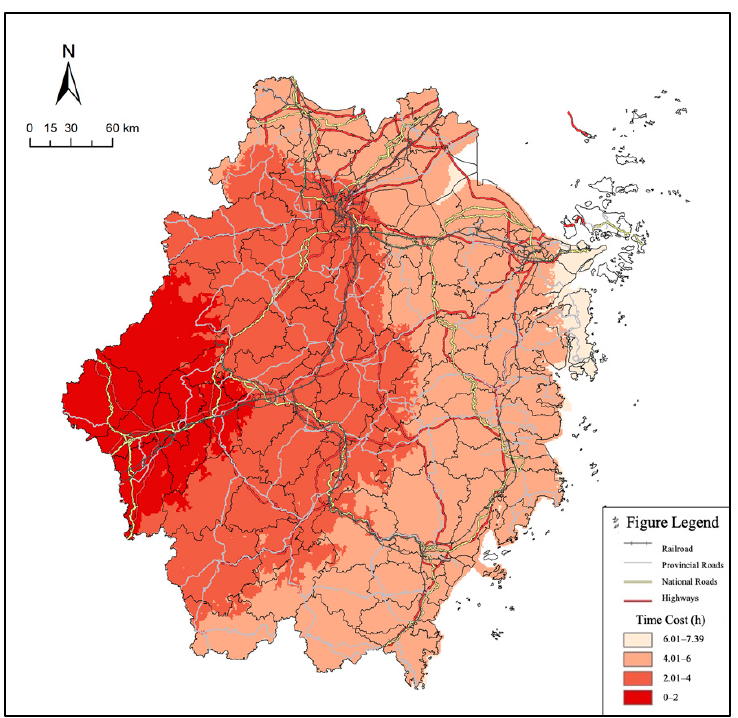
Figure A1. Time cost of reaching Qianjiangyuan National Park in Zhejiang Province.